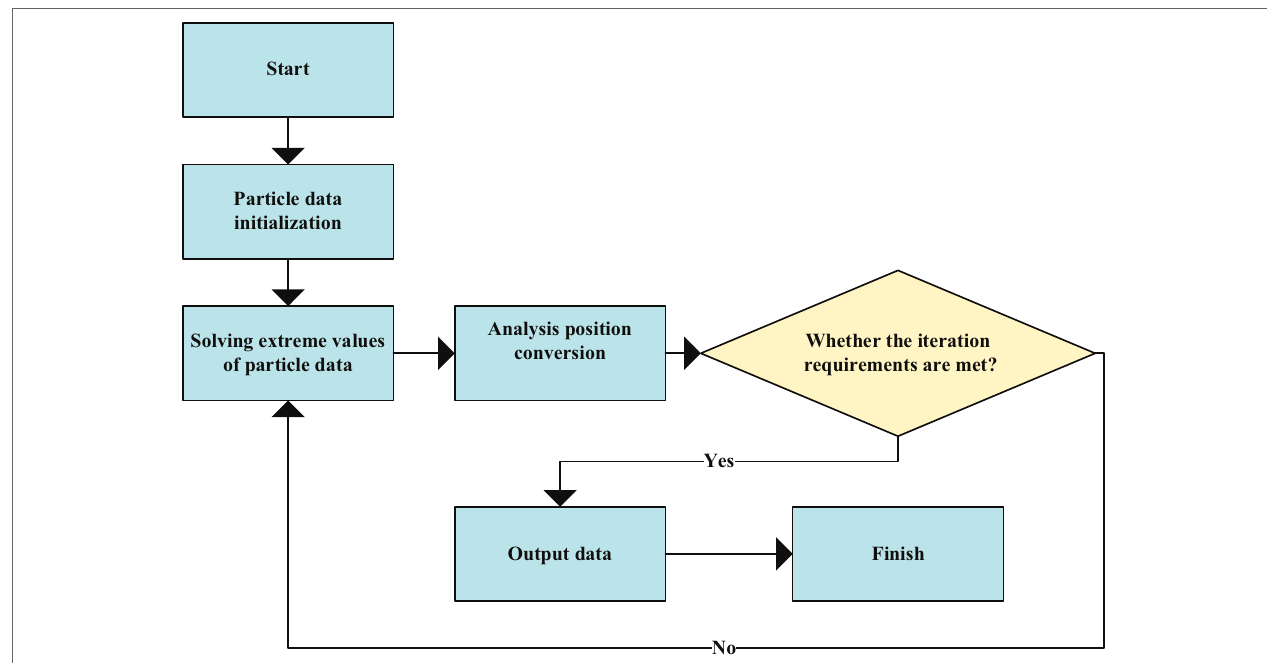
FIGURE 16 | Pre-processing flow of SARIMA-BP model